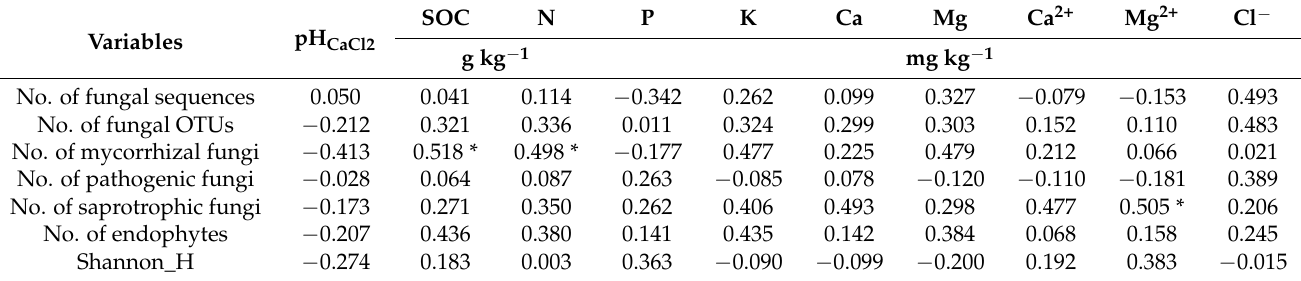
Table 6. Pearson’s correlation between chemical soil parameters (pH CaCl2 , SOC, total N, P, K, Ca, and Mg, and also mobile Ca 2+ , Mg 2+ , and Cl − ) and the parameters of soil fungi in the studied